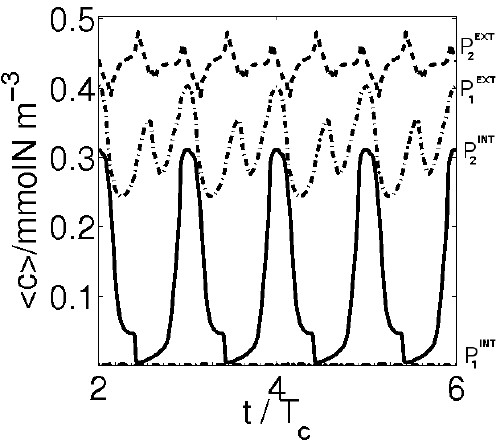
Fig. 9. Tracers released in the upwelling region [0 , 1] × [2 , 2 . 25] at t = 5 . 84 T c . The colors denote the time they have been in the observation region (backward residence time).